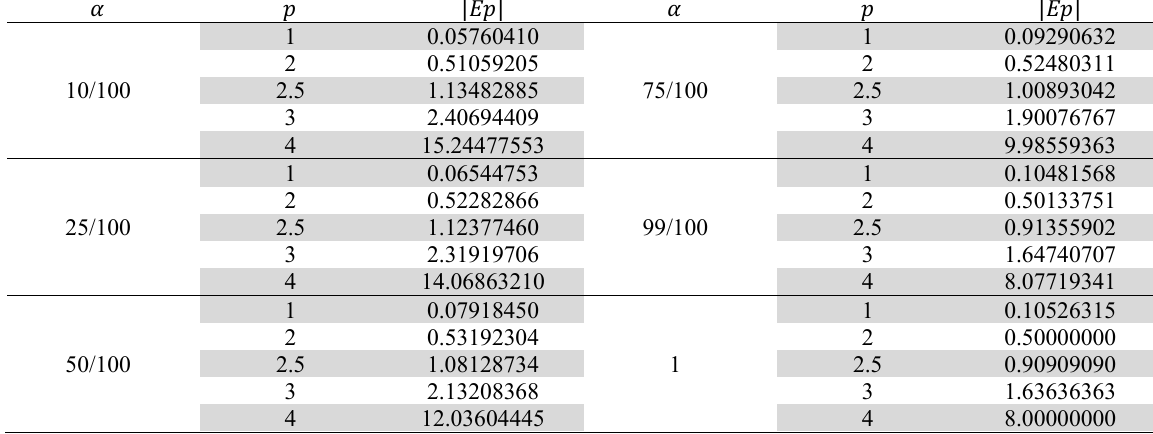
Numerical results of | 𝐸 ( 𝑝 )| for the various value of 𝑝 and 𝛼 𝛼 𝑝 | 𝐸𝑝 | 𝛼 𝑝 | 𝐸𝑝 |